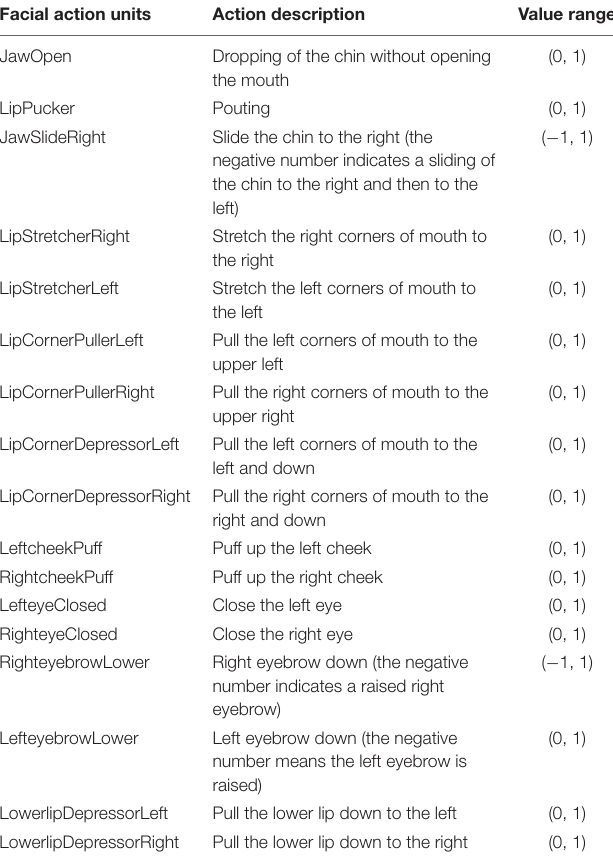
TABLE 1 | The specific meaning of each